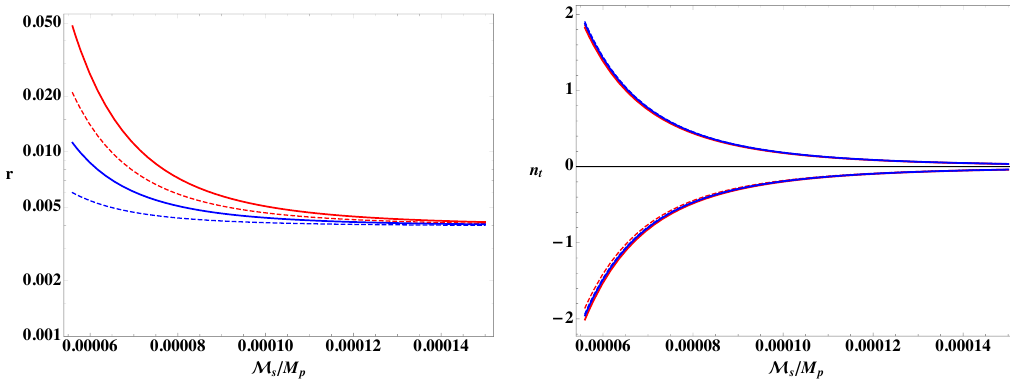
Figure 3 . In the above plots, we depict ( r; n t ) versus the scale of non-locality M s for the form- factor (3.19) and N (cid:3) = 55. We have taken (cid:11) 2 = (cid:0) 0 : 06 ; (cid:0) 0 : 04 ; (cid:0) 0 : 025 ; (cid:0) 0 : 01 (corresponding to solid red, dashed red, solid blue and dashed blue lines respectively). In the right panel the lines with n t > 0 correspond to (cid:11) 1 = 2 : 5 and the lines with n t < 0 correspond to (cid:11) 1 = (cid:0) 2 : 5. In both the plots, we can notice that in the limit M s ! M p we recover the predictions of the local R 2 model.